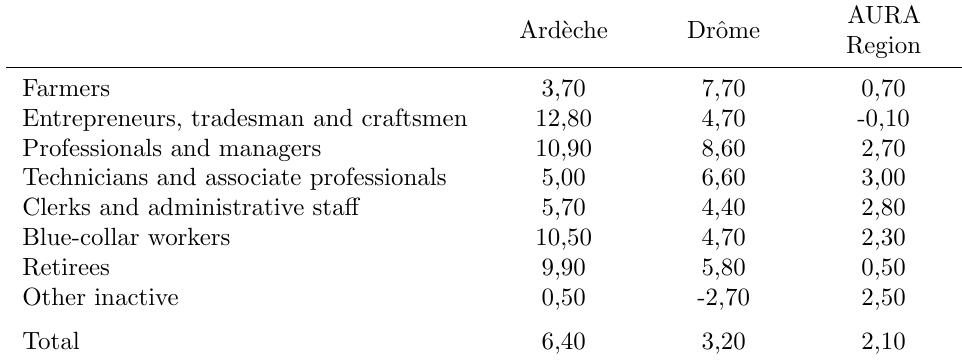
Table 4: Net internal migration rate per socio-professional status, 2016, per 1000 habitants AURA Ard`eche Drˆome Region Farmers 3,70 7,70 0,70 Entrepreneurs, tradesman and craftsmen 12,80 4,70 -0,10 Professionals and managers 10,90 8,60 2,70 Technicians and associate professionals 5,00 6,60 3,00 Clerks and administrative staff 5,70 4,40 2,80 Blue-collar workers 10,50 4,70 2,30 Retirees 9,90 Other inactive Total Source : INSEE